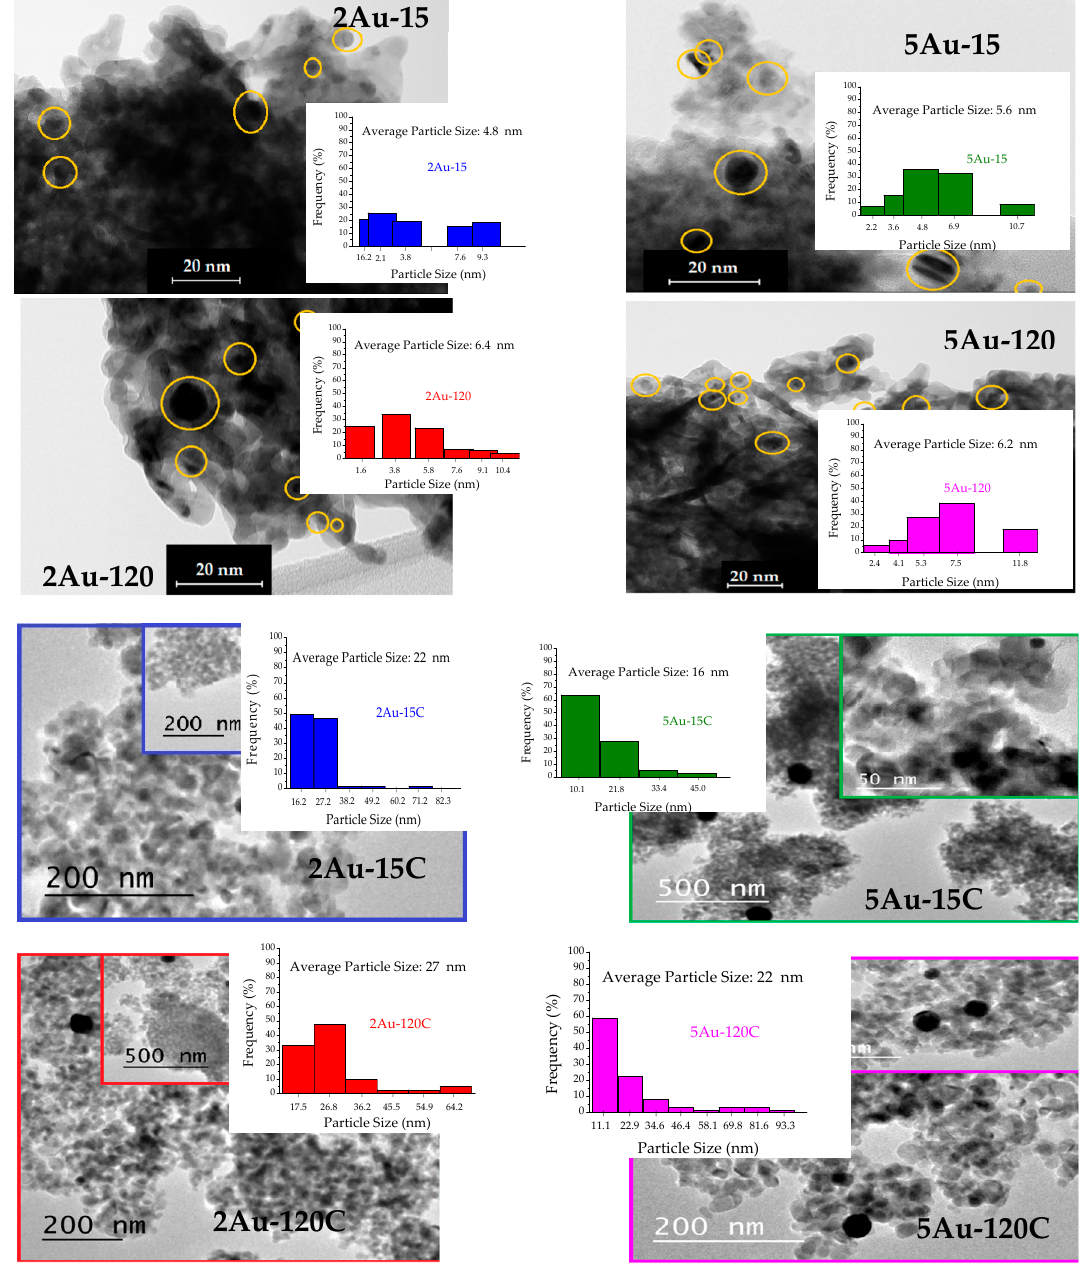
Figure 2. TEM micrographs of the non-calcined and calcined catalysts including the corresponding particle size distributions of the metal nanoparticles.